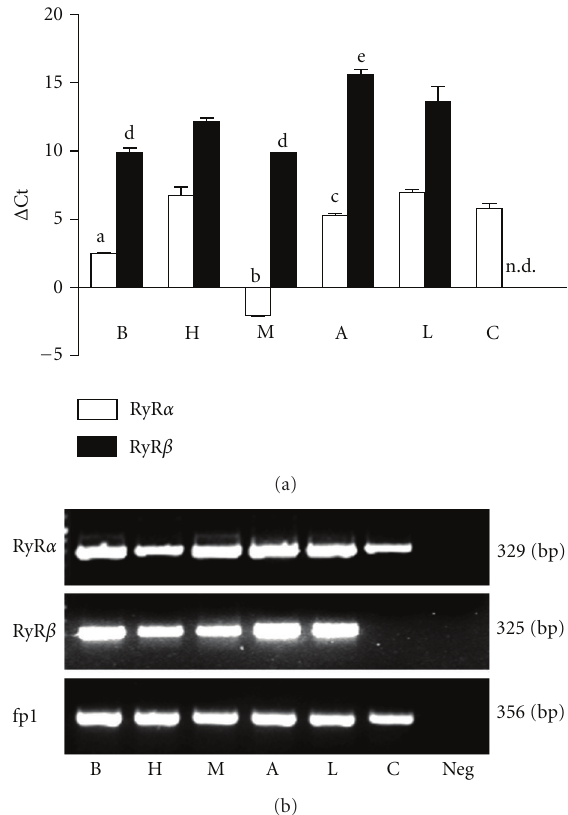
Figure 1: Expression of ryanodine receptor alpha (RyR α ) and beta (RyR β ) isoform mRNAs in brain (B), heart (H), skeletal muscle (M), semicircular canal ampulla (A), semicircular canal arm (C), and whole labyrinth (L) of the frog. (a) mRNA levels were measured by real-time polymerase chain reaction relative to the fp1 internal standard (see Materials and Methods), and the values obtained were reported as Δ Ct. Bars represent the mean ± SEM of at least 4 di ff erent experiments, each from di ff erent RNA extracts. a, P < 0 . 001 versus H, A, L, C; b, P < 0 . 001 versus B, H, A, L, C; c, P < 0 . 05 versus H, L; d, P < 0 . 05 versus H, A, L; e, P < 0 . 05 versus H, L. (one-way ANOVA followed by Newman-Keuls Q test). n.d., not detected. When not present, SEM was within the symbol area. Note that high Δ Ct values reflect low mRNA expression levels. (b) Gel electrophoresis of PCR products. The PCR products were of the expected size: RyR α , 329 bp; RyR β , 325 bp; fp1, 356 bp. Neg: reaction without template. Similar results were obtained from at least four di ff erent frog RNA